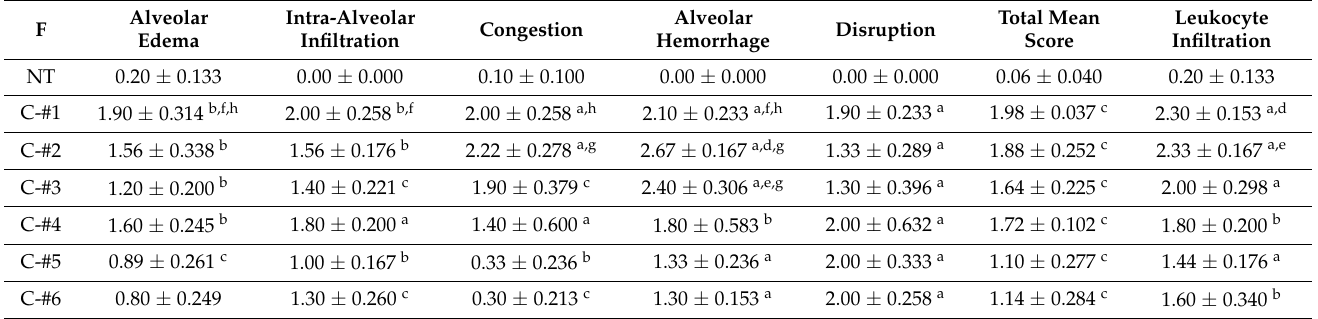
Table 5. Statistics of various indices based on histopathological evaluation of the lungs from female mice.